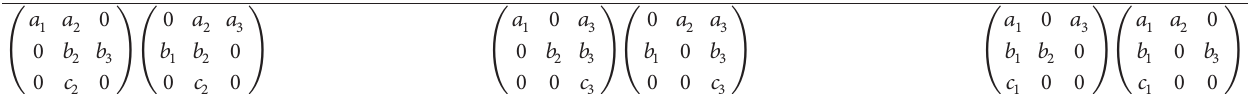
Third row with two zeros, a pair of orthogonal columns, non-orthogonal